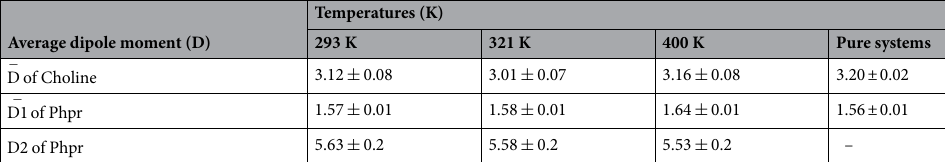
Table 3. The average dipole moment vector in Debye (D) and standard deviation of the distribution for the studied systems in a pure state and mixture at the considered temperatures in 0.1 MPa. With respect to the fact that the normalized distribution of dipole moment of Phpr have two Gaussian-typ behavior, therefore, two average dipole moment were reported ( − D1 and − D2 ).